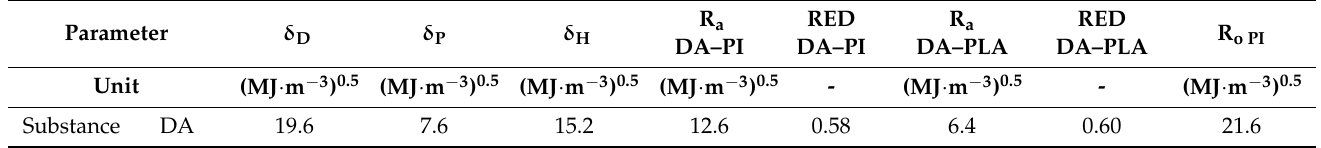
Table 3. Calculated Hansen solubility parameters of dopamine (DA).